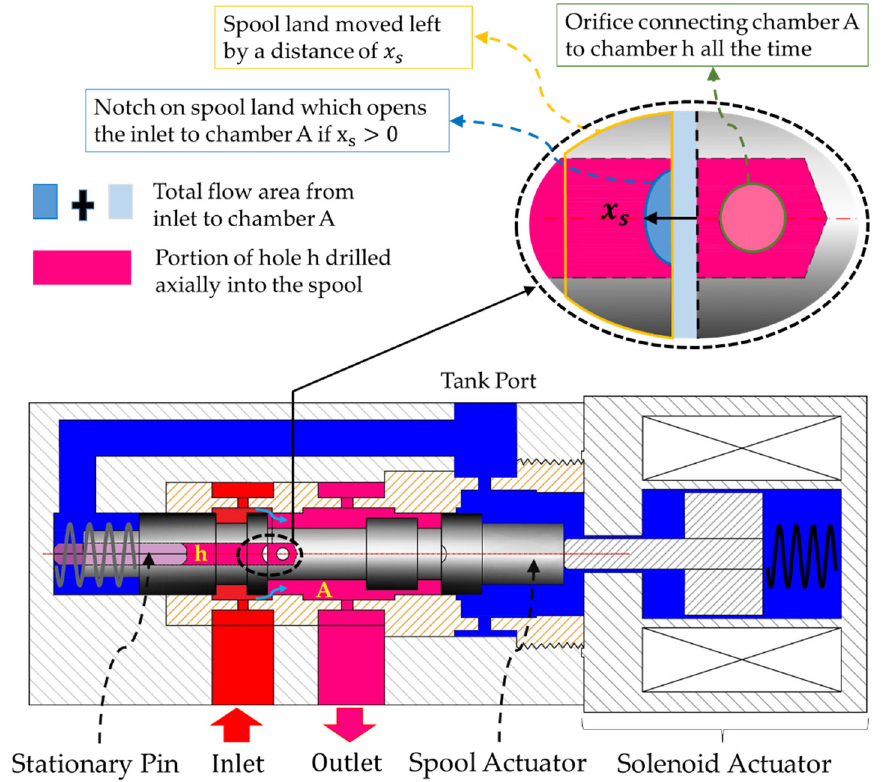
Figure 2. Detailed schematic of the pin-type spool actuator.